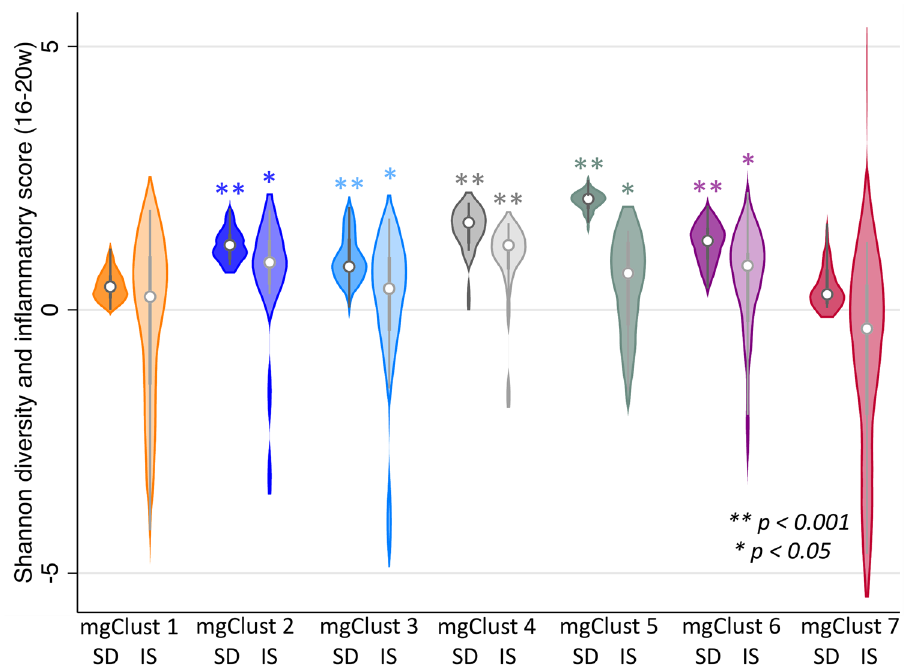
Figure 5. Median Shannon diversity indices (SD) and inflammatory scores (IS) by metagenomic clusters (mgClust) in vaginal specimens collected between 16–20 gestational weeks. p values calculated by weighted linear regression of SD and IS in each mgClust compared to L. crispatus -dominant mgClust 7, adjusting for HIV serostatus at